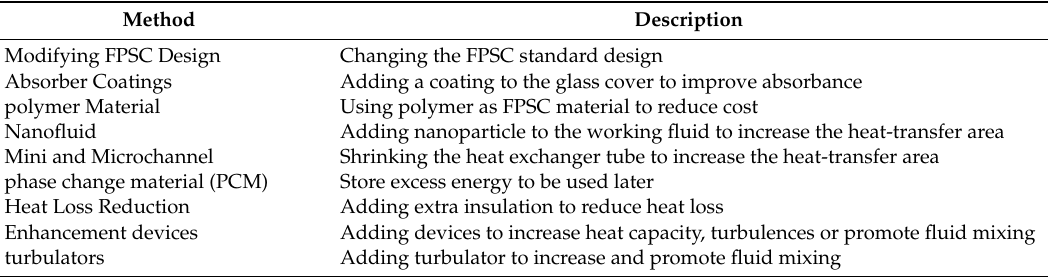
Table 1. Summary of methods studied in FPSC thermal performance